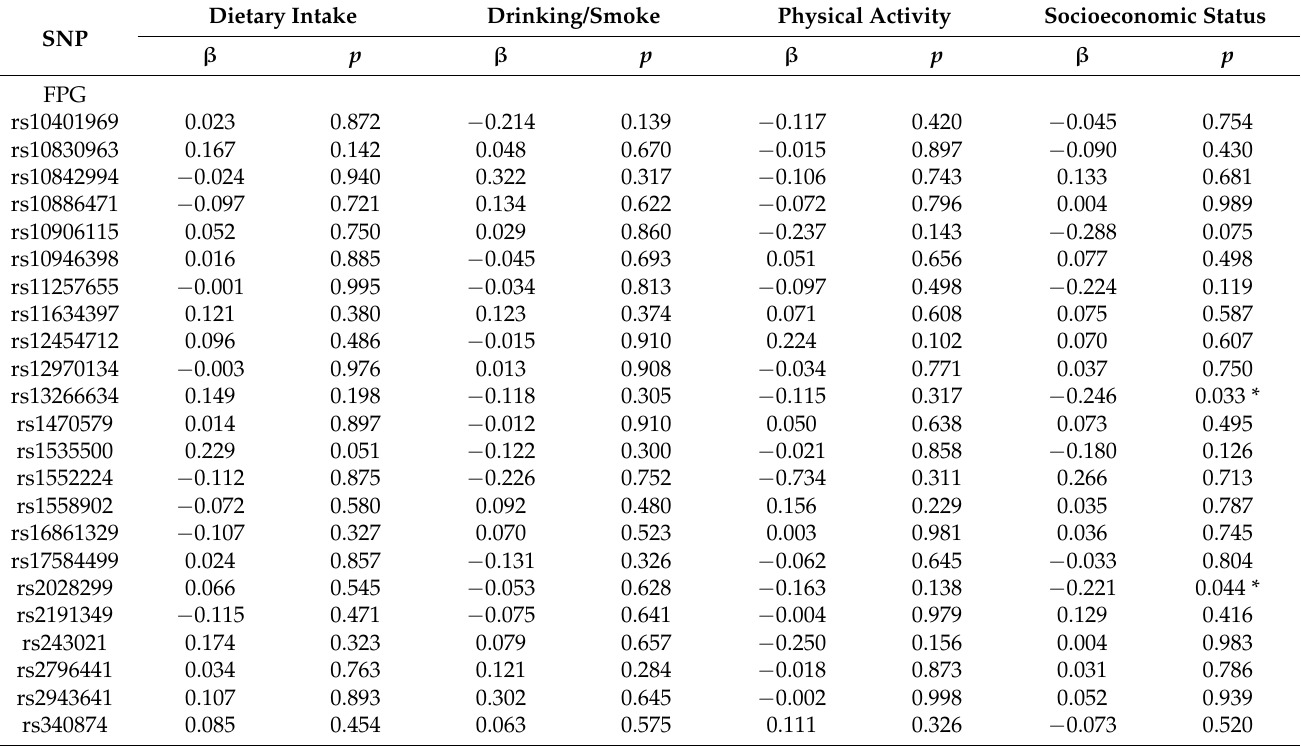
Table 3. Interactions of gene–environment on FPG and